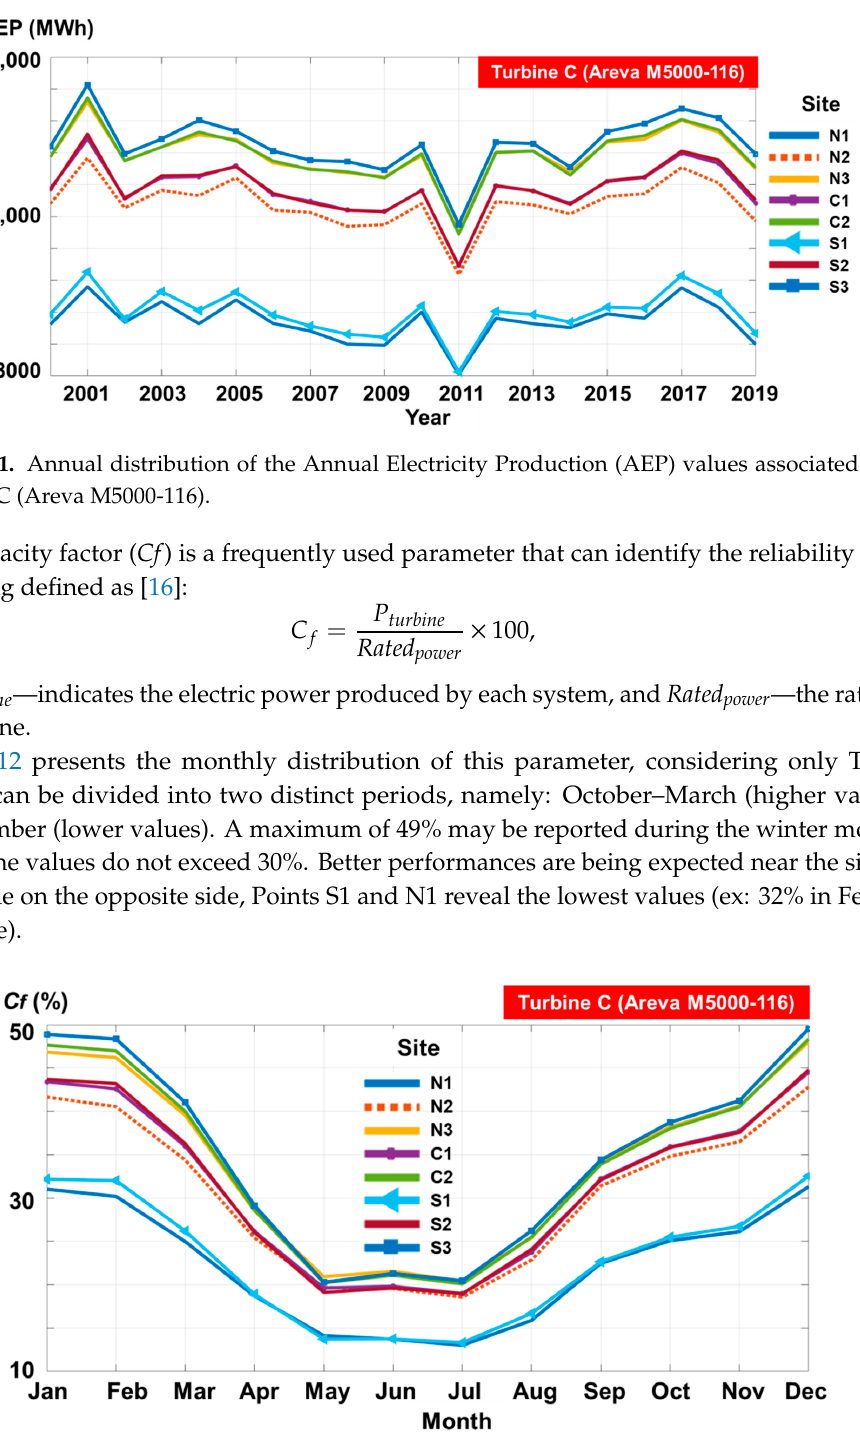
Figure 12. Capacity factor—monthly distribution associated with Turbine C (Areva M5000-116).